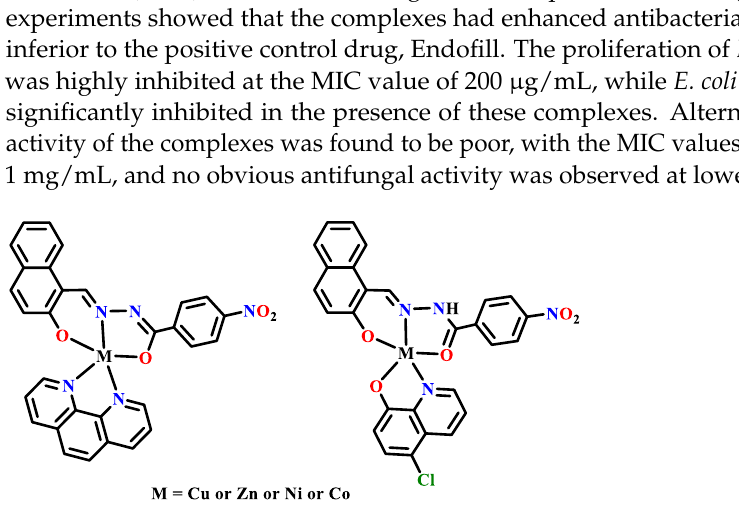
Figure 4. The transition metal complexes of naphthylhydrazone with p -nitrobenzamide as a side chain together with o -phenanthroline or 5-chloro-8-hydroxyquinoline as the